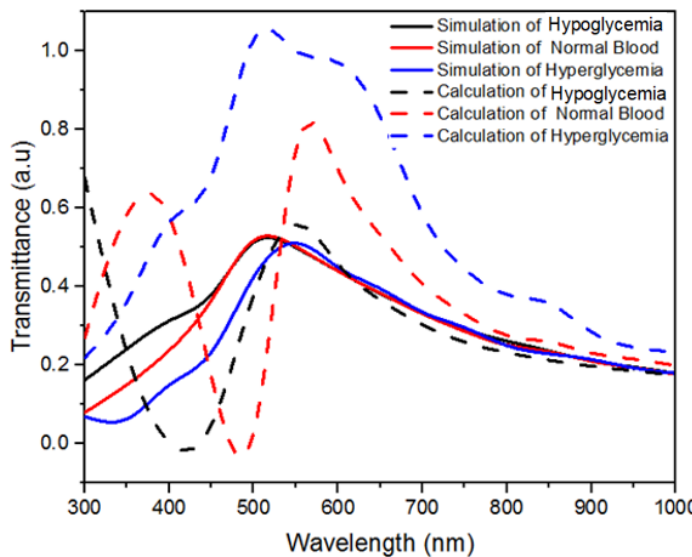
Figure 10. Transmittance of ZnO nanostructures—simulation and calculations results with variations of glucose concentration in blood media.